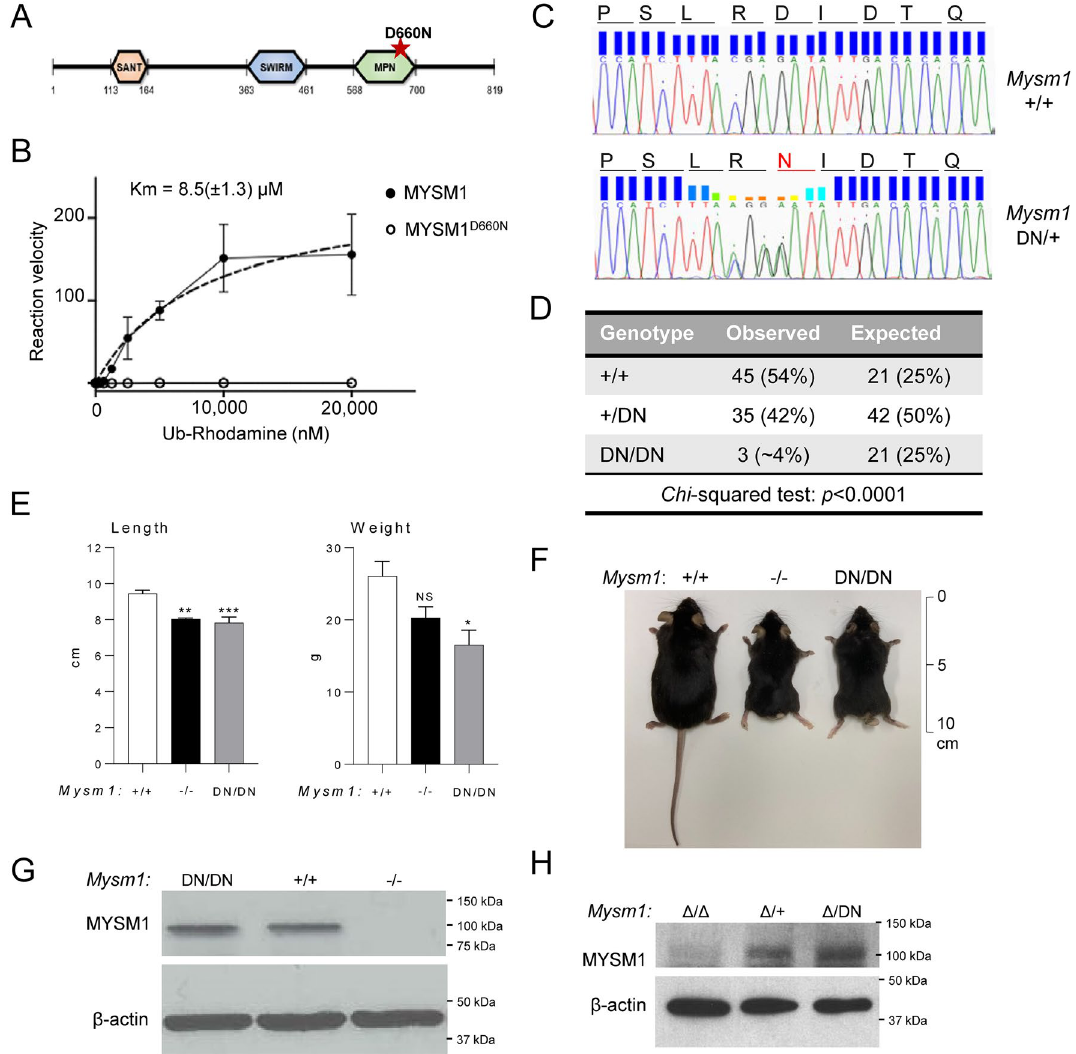
Figure 1. Development and validation of the mouse model expressing a catalytically inactive MYSM1. ( A ) Domain structure of the mouse MYSM1 protein indicating the mutation in the MPN catalytic domain predicted to render the protein catalytically inactive. ( B ) Catalytic activity assay of recombinant mouse MYSM1 against ubiquitin-Rhodamine substrate demonstrates that the D660N mutation results in a full loss of the DUB catalytic activity. ( C ) Sanger sequencing of the Mysm1 locus in the genomic DNA of wild type control and Mysm1 DN/+ heterozygous mice, indicating the DNA sequences and the corresponding amino acid sequences of the wild type and mutant proteins. ( D ) High embryonic lethality of Mysm1 DN/DN mice: offspring genotypes obtained from the mating of two Mysm1 +/DN heterozygous parents show strong deviation from expected Mendelian ratios. ( E ) Length and weight of the age- and sex- matched mice of Mysm1 +/+ , Mysm1 −/− and Mysm1 DN/DN genotypes; bars represent means ± SEM, statistical analysis with ANOVA comparing each group to the control, * p < 0.05, ** p < 0.01, *** p < 0.001, NS—not significant. ( F ) Representative image of the age- and sex- matched mice of Mysm1 +/+ , Mysm1 −/− and Mysm1 DN/DN genotypes, showing reduced body size and tail dysmorphology. ( G ) Western blot of mouse bone marrow cell lysates showing comparable MYSM1 protein levels in Mysm1 +/+ and Mysm1 DN/DN samples. ( H ) Western blot of splenocyte lysates from tamoxifen-treated Cre ERT2 transgenic mice of Mysm1 fl/+ , Mysm1 fl/fl , and Mysm1 fl/DN genotypes, showing strong depletion of MYSM1 protein in the Mysm1 Δ/Δ cells, and comparable MYSM1 protein levels between Mysm1 Δ/+ and Mysm1 Δ/DN samples. β-actin is used as a loading control in ( G , H